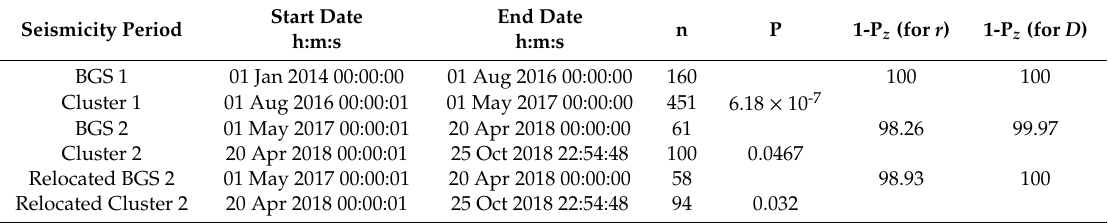
Figure 9. Magnitude (M)-frequency (N) diagram of the seismicity state BGS 1 (number of events N b , seismicity rate r b , correlation coe ffi cient R) and of the hypothetical foreshock sequence (FOR-cluster 1; N f , r f , as in Figure 8) ( a ); b ML and b GR are b-value estimates from the maximum likelihood approximation and the weighted least-square method, respectively. The b-value in BGS 1 is significantly lower than that in FOR-cluster 1 period. This is systematically valid for M c varying from 1.1 to 2.7 with step 0.1 ( b ). For M c ≥ 2.0 (vertical red line) the changes in both b and r are highly significant (see Section 3.2.1). Seismicity testing showed that the hypothetical FOR period (cluster 1) does not really represent foreshock activity but it has been a transient swarm activity (see Section 3.2.1). Table 1. Results of testing for the b, r, and < D > changes within radius of R = 30 km from the 25 October 2018 mainshock epicenter. Lower magnitude threshold is M c = 2. Key: BGS = background seismicity; n = number of events; P = probability for the significance level of b-value change according to Utsu-test; P z = probability according to